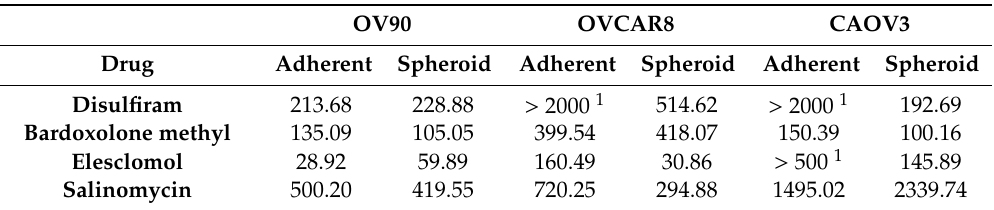
Table 1. Summary table of half maximal toxicity nM concentrations of the drugs against each cell line under adherent or TIC culture conditions.